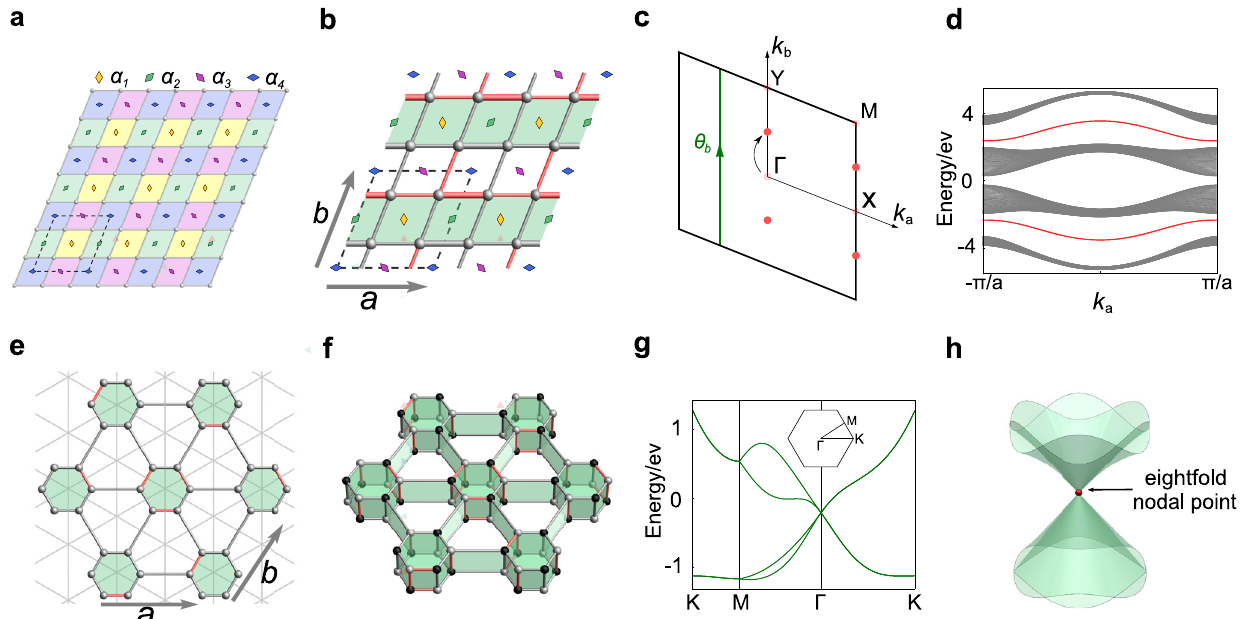
Fig. 2 | Models and physical consequences of projective symmetry algebras. a The canonicalmodelfor P 2. The dashedline marks the unit cell. The four classes of translation-related rotation centers are colored in red, green, purple and blue, respectively. Each rotation center is the center of a plaquette shadowed with the same color of the rotation center. The four colors correspond to the four α -invar- iants in Table 1. b The model of P 2 that realizes the projective symmetry algebra (PSA) with α 1 = α 2 =1 and α 3 = α 4 = − 1. The dashed line marks the unit cell, which contains four sites. The bonds with red color have a negative hopping amplitude, which makes the shaded plaquettes having a π fl ux. a and b Are lattice